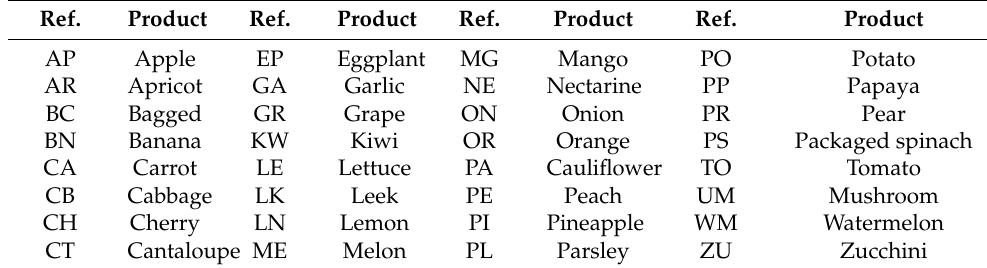
Table 2. References for the horticultural products in the crates. Ref.